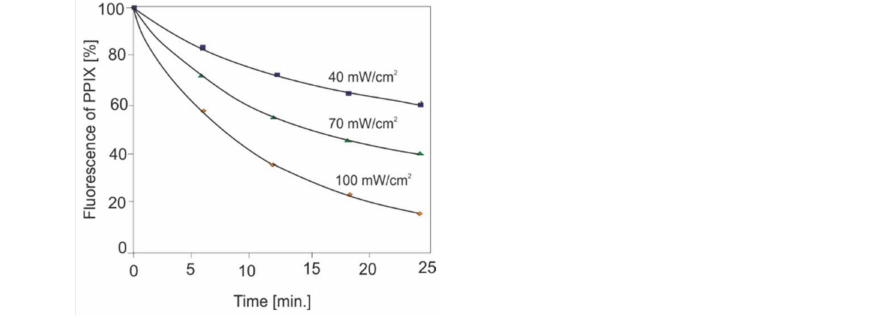
Figure 14. Photobleaching effect during the irradiation of skin actinic keratosis with